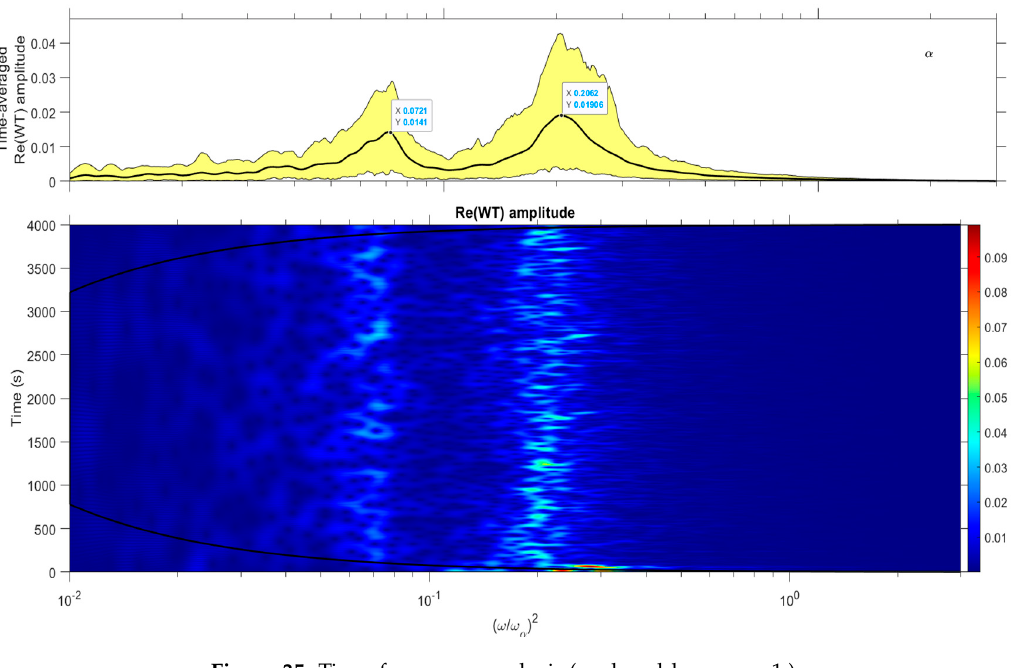
Fluids 2020 , 5 , x FOR PEER REVIEW Figure 35. Time–frequency analysis ( 𝛼 , closed-loop, ν = 1 ). Figure 35. Time–frequency analysis ( α , closed-loop, ν = 1 ).